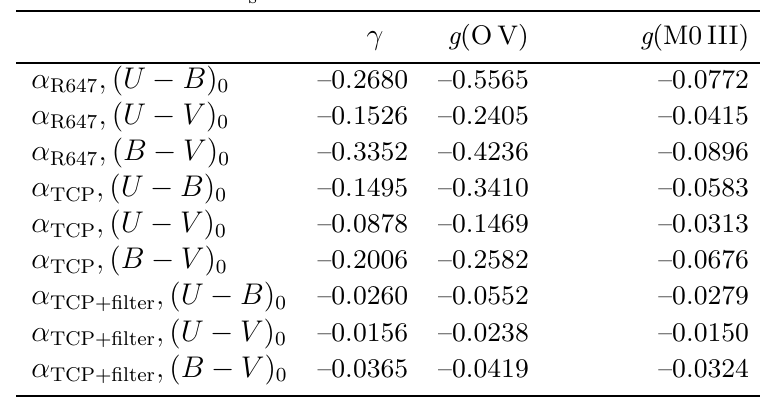
Table 1. Second order extinction coefficients γ and g for WET R647, TCP with no filter and TCP with the filter #92 passbands for the Mol˙etai Ob- servatory, when h = 220 m, T = 3 mm, A s = 0.2 and b s =